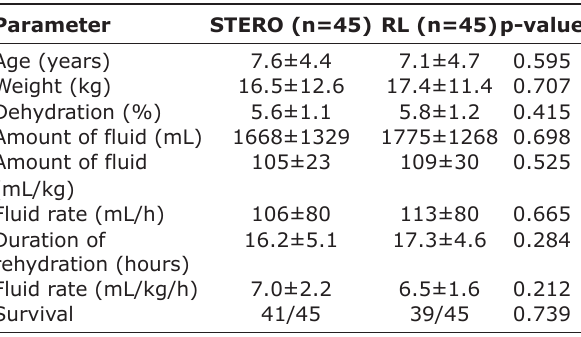
Table-2: Demographic data of 90 dehydrated dogs receiving either acetated (STERO) or lactated (RL) rehydration fluids.